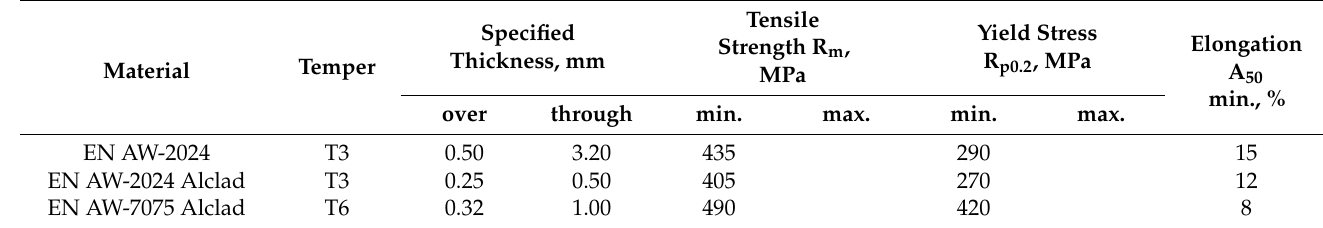
Table 2. Basic mechanical properties of test sheets